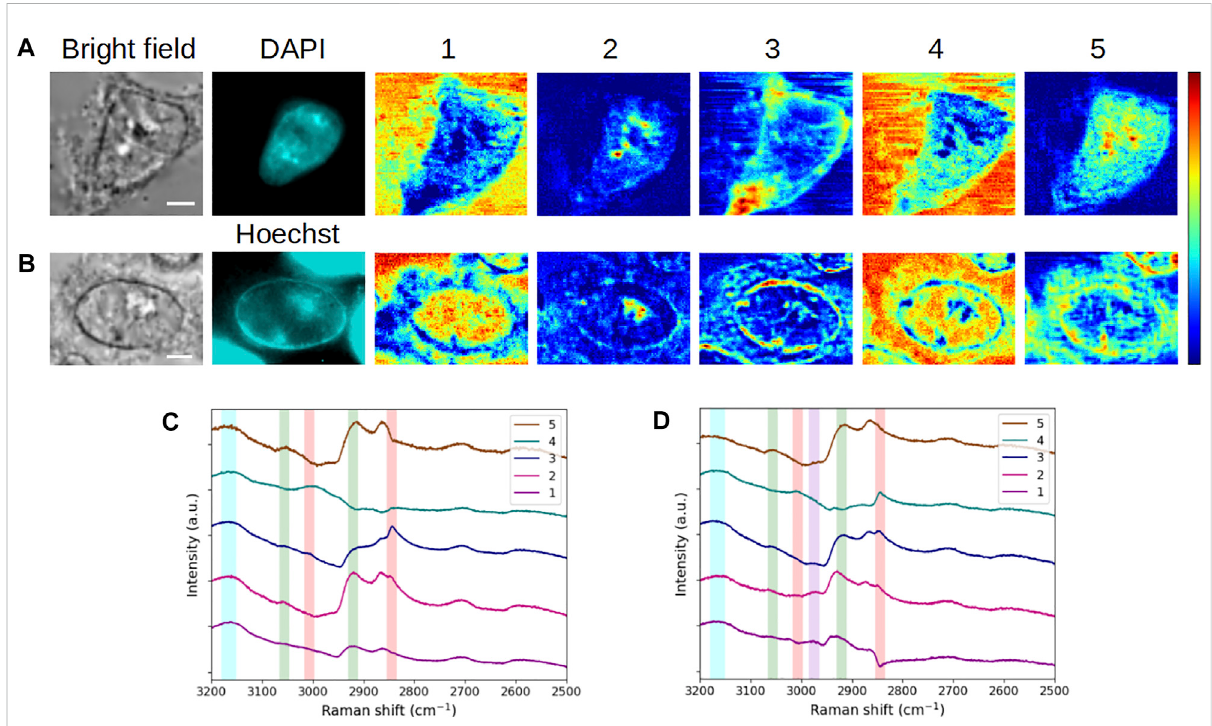
FIGURE 5 Comparative analysis of interphase (A,C) fi xed and (B,D) living HEK293 cells. (A, B) Bright- fi eld and fl uorescence images and concentration maps obtained for the fi ve computed components. The scale bar corresponds to 5 μ m. (C, D) Spectra corresponding to (A, B) , respectively. Vertical bars highlight the presence of lipids (red), proteins (green), DNA/RNA (violet), and water (blue). The fi xed and living cells were stained with DAPI and Hoechst 33342,